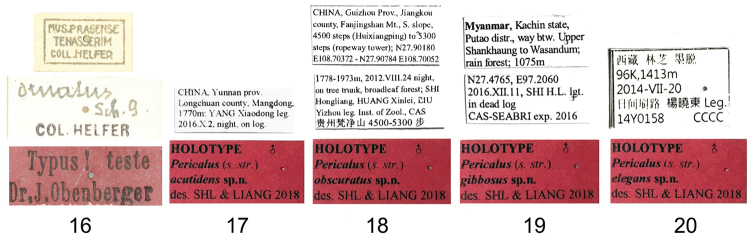
Labels of types: 16
P.
ornatus
ornatus Schmidt-Göbel, syntype (NMPC) 17
P.
acutidens sp. n., holotype (IZAS) 18
P.
obscuratus sp. n., holotype (IZAS) 19
P.
gibbosus sp. n., holotype (IZAS) 20
P.
elegans sp. n., holotype (IZAS);